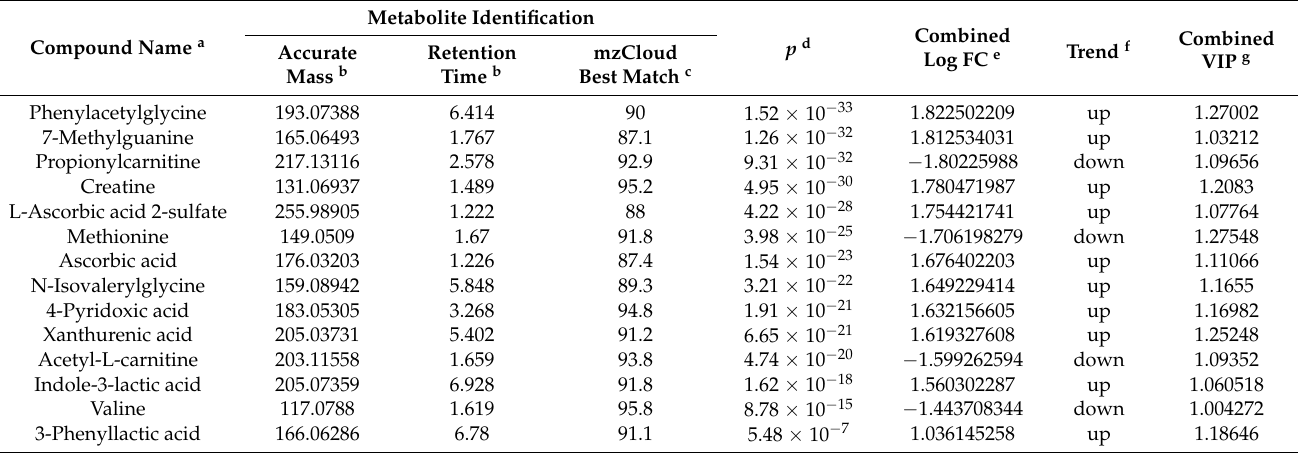
Table 1. Differential metabolites for estazolam fatal intoxication in plasma